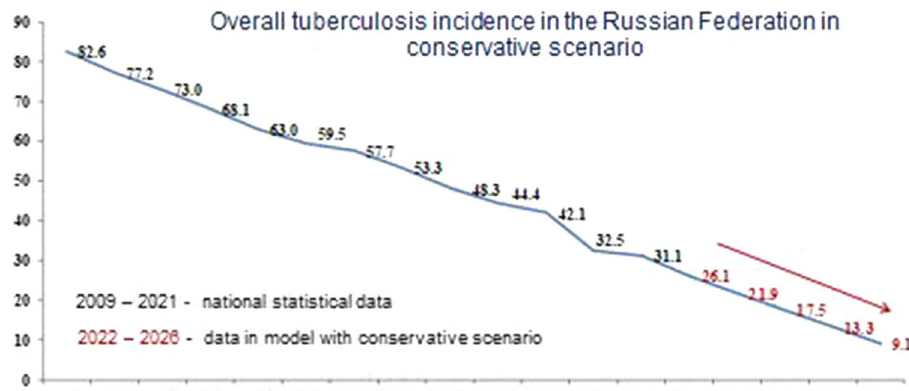
Fig. 3 Forecast of the overall tuberculosis incidence in the Russian Federation with the optimistic